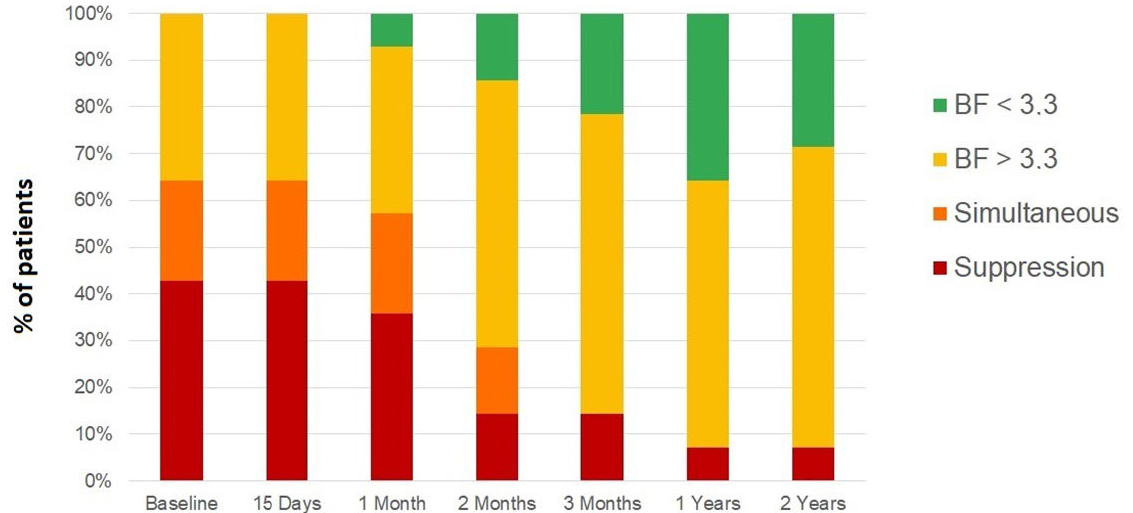
Figure 2. Binocular function (BF) score evolution of strabismic amblyopia group from the previous visit to 15 days, 30 days, 60 days and 90 days of treatment, as well as at one and two years after the completion of